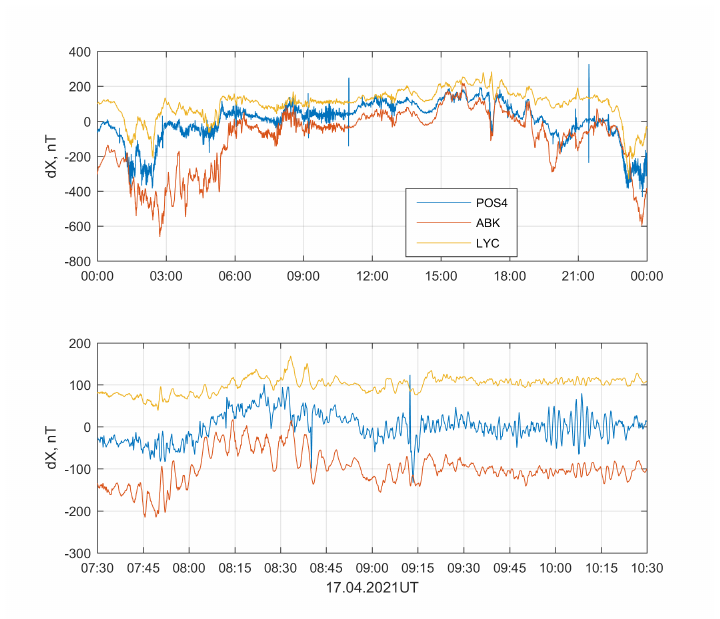
Figure 15. Comparison of the X-component variations obtained using POS-4 at the WSE observatory and at the INTERMAGNET ABK and LYC observatories (1-second values). The upper panel shows the variations for the day of 17.04.2021, the lower panel is a part of the data from 07:30 to 10:30UT, showing some details of the